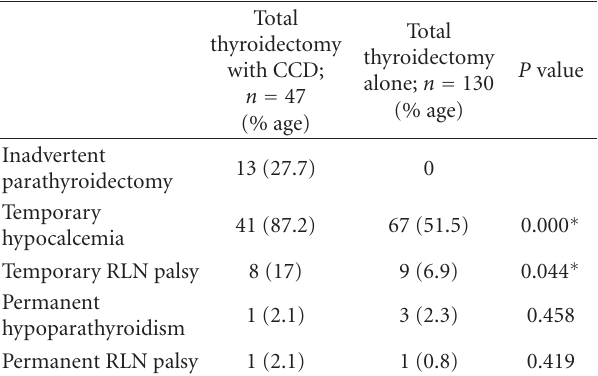
Table 4: Comparison of morbidity following total thyroidectomy with CCD ( n = 47); with total thyroidectomy alone (benign thyroid disorders; n =